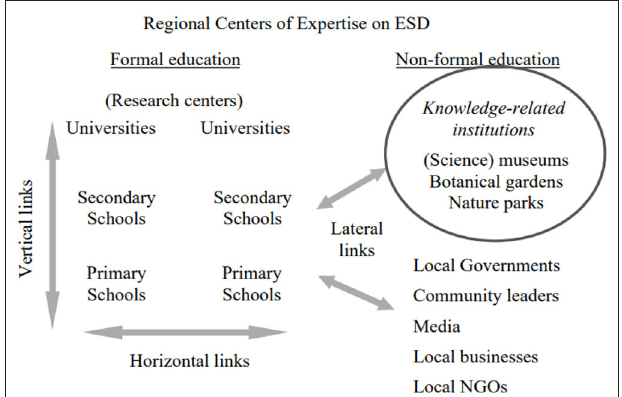
FIGURE 4 | Standard RCE framework and the actors, and the source is UNU (2004).